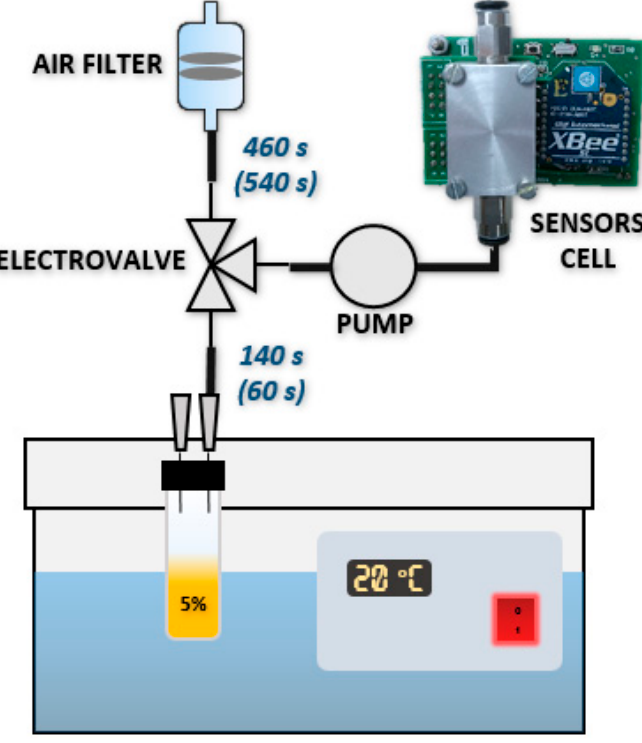
Figure 10. Measurements set-up scheme.